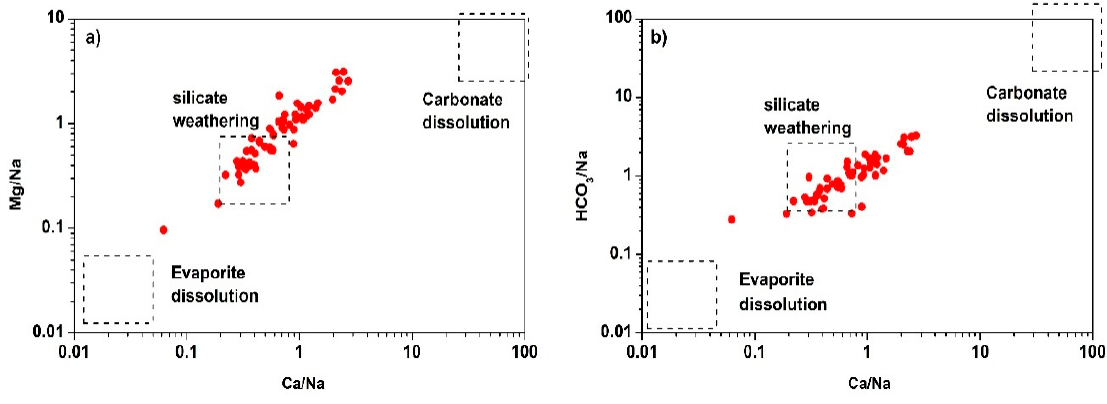
Figure 6. Plots of ( a ) Na-normalized Ca 2+ versus Mg 2+ ( b ) Na-normalized Ca2+versus HCO 3 − .